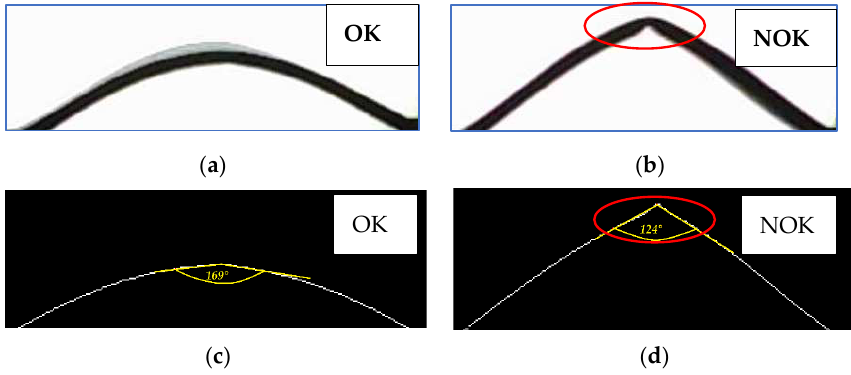
Figure 13. Textile profile photo processing for fabric type GC: ( a ) textile GC-u is OK—without loss of stability; ( b ) Textile GC-o is NOK– loss of stability detected; ( c ) the curve and the deformation angle reading; ( d ) the angle of deformation of the textile after its loss of stability.